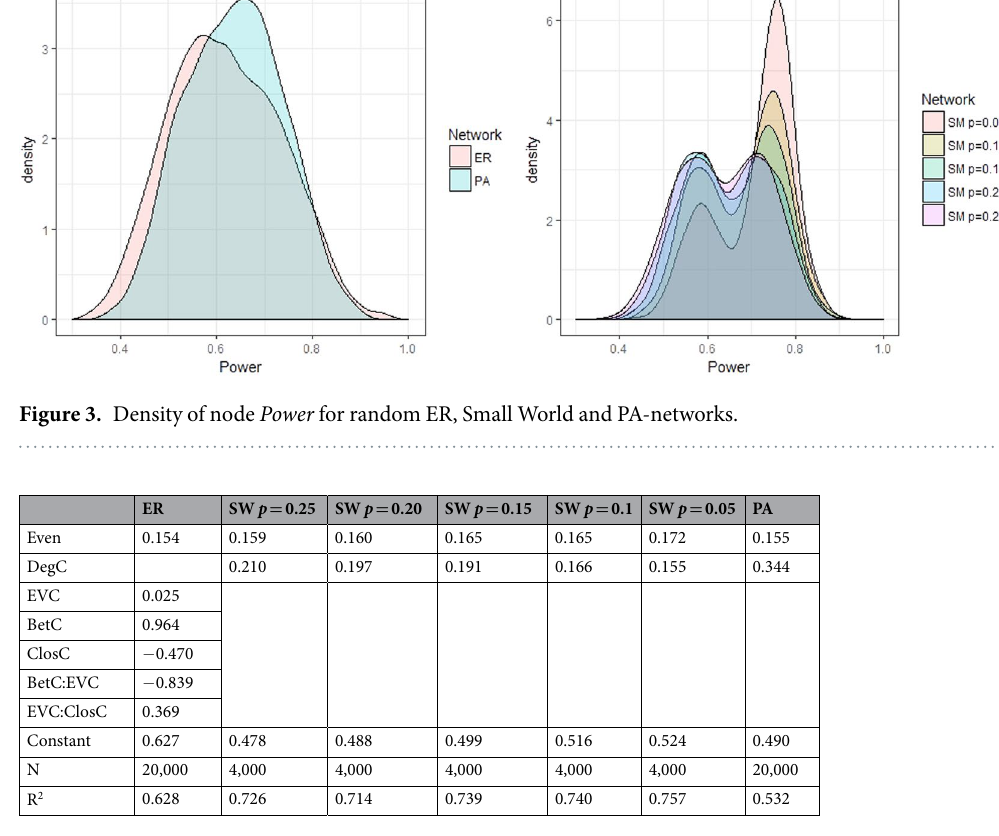
Table 5. Regression results, standardized, dependent variable Power . Even = variable indicating an even degree, EVC = Eigenvector centrality, BetC = Betweenness centrality, DegC = Degree centrality, ClosC = Closeness centrality. Interaction in uncentered